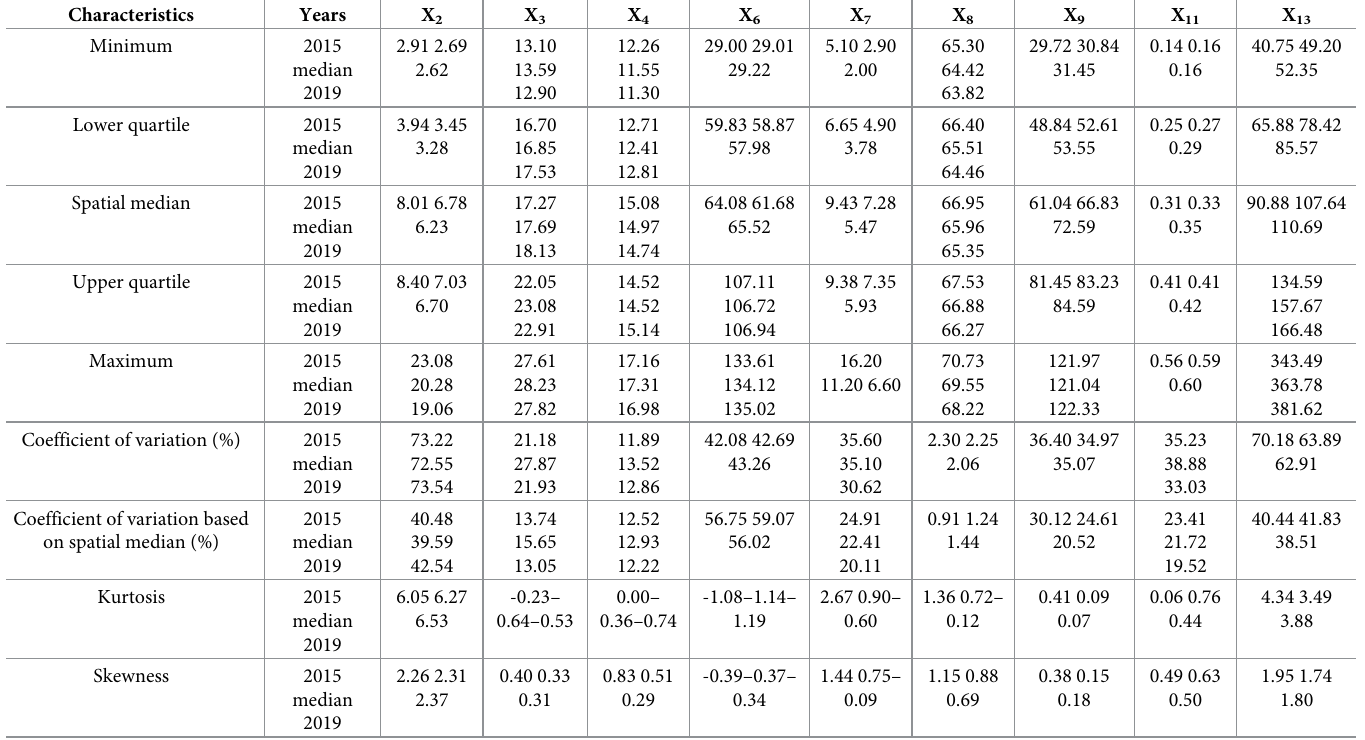
Table 4. Basic descriptive statistics characterising the diagnostic features for 3SI countries.